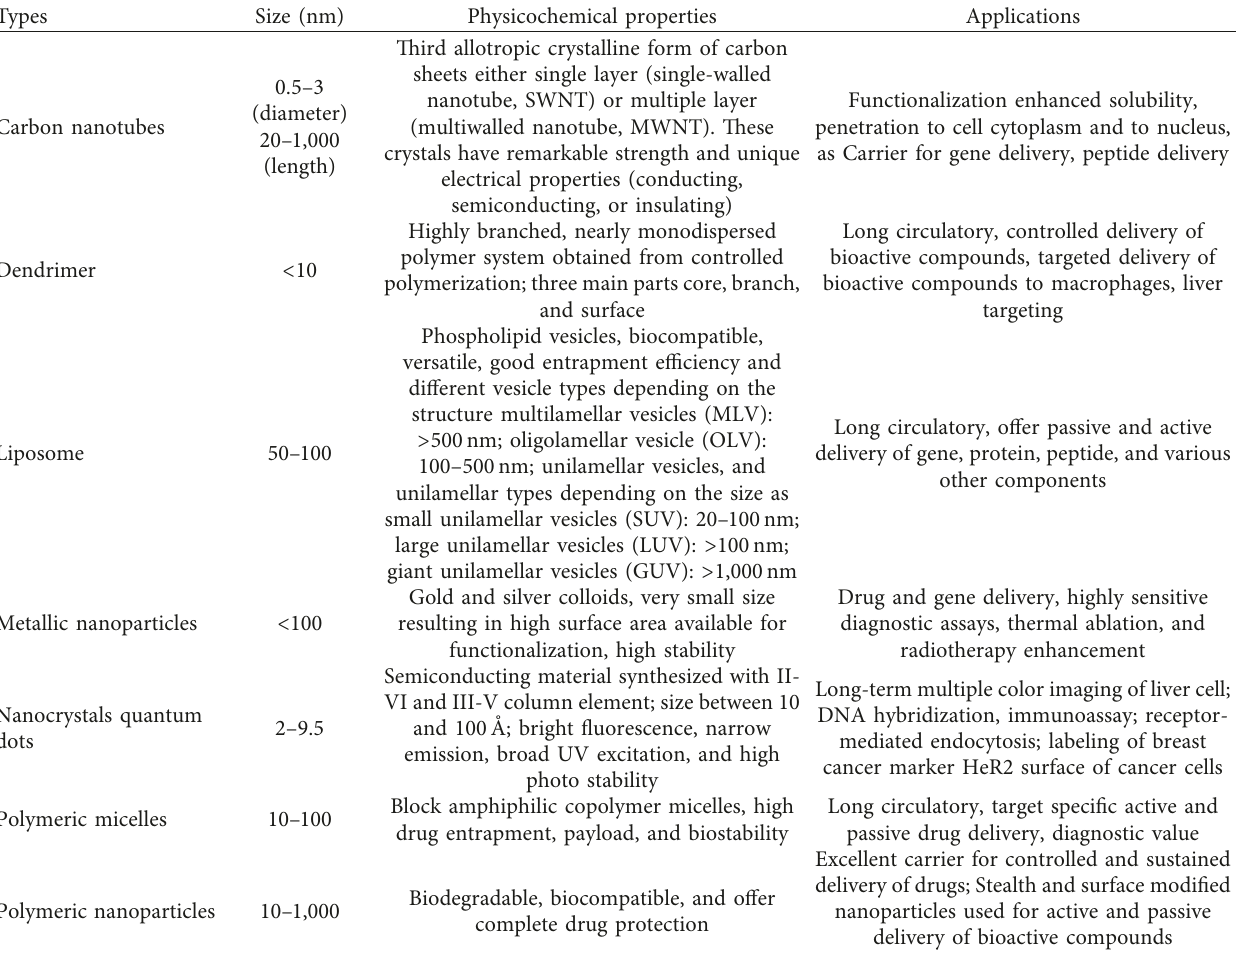
Table 1: Physicochemical properties and applications of various